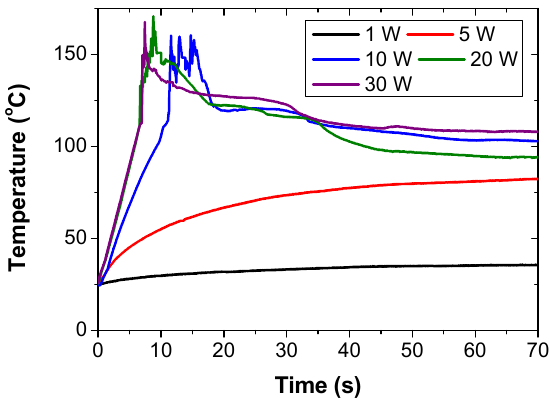
Figure 4. Changes in temperature of solder paste on a polyimide sheet by MW irradiation at 1, 5, 10, 20, and 30 W output powers for 70 s.